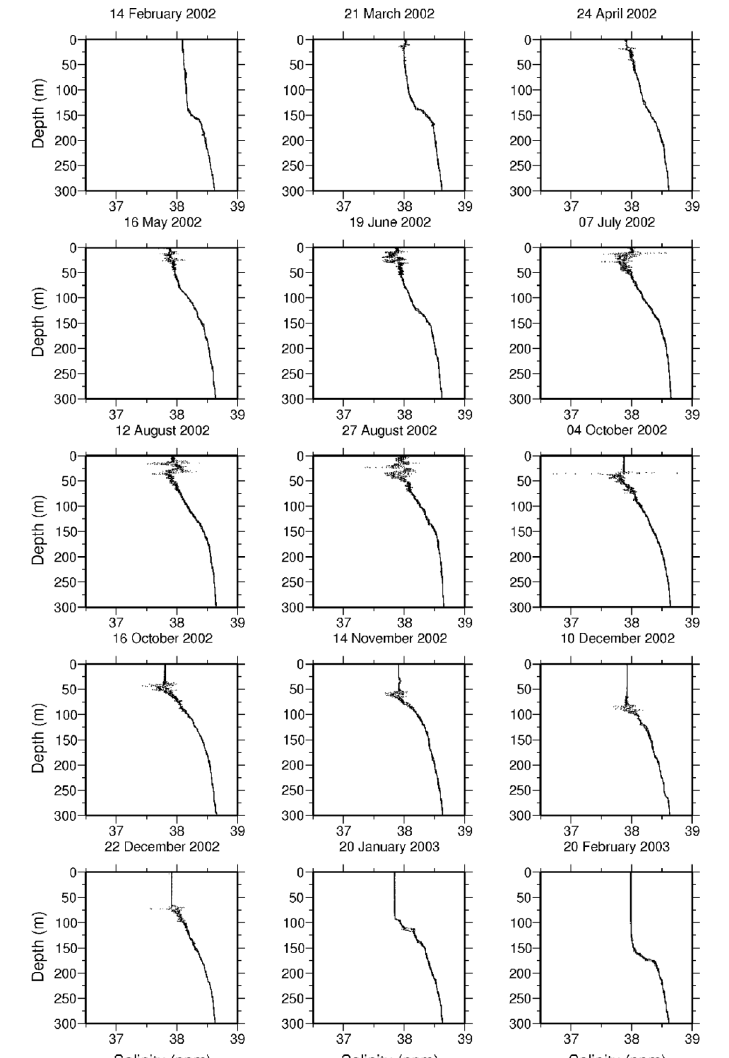
Fig. 2. Salinity profiles in the Gulf of Naples from the sea surface to the bottom, at 300 m in depth, measured across 15 different periods between February 2002 and February